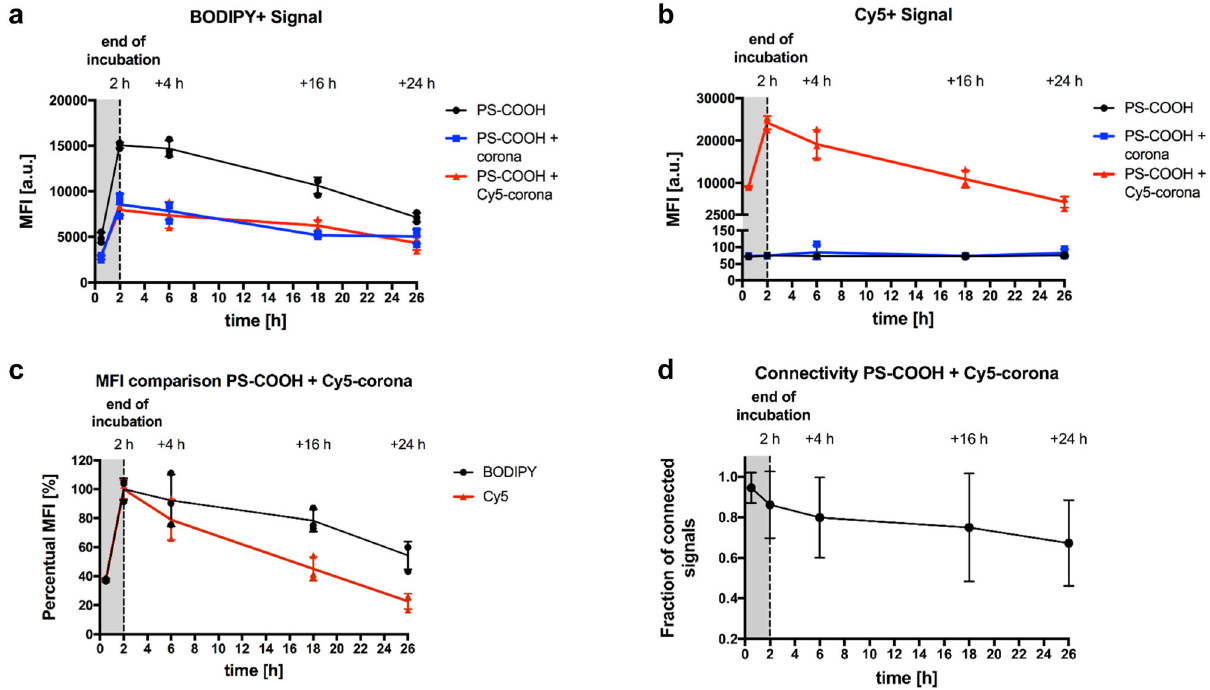
Fig. 4 | Flow cytometry and CLEM connectivity analysis reveal a slow separa- tion of NP and protein corona after cell uptake. RAW264.7 cells were incubated with 150 µ gmL − 1 of carboxyl-functionalized PS NPs. Untreated NPs, NPs with an unlabeledproteincorona,andNPswithaCy5-labeledproteincoronawereusedfor the uptakeexperiment. The cellswereincubatedwith the NPs for2h (dottedline). Subsequently,theNP-containingsupernatantwasremovedandreplacedwithfresh culture medium without NPs. a Flow cytometry was performed to measure the median fl uorescenceintensity (MFI) of BODIPY (PSNPs). b TheMFI of Cy5(labeled corona proteins) was measured for the same events. The gating strategy for fl ow cytometry is provided in Supplementary Fig. 2. c The percentual MFI was plotted